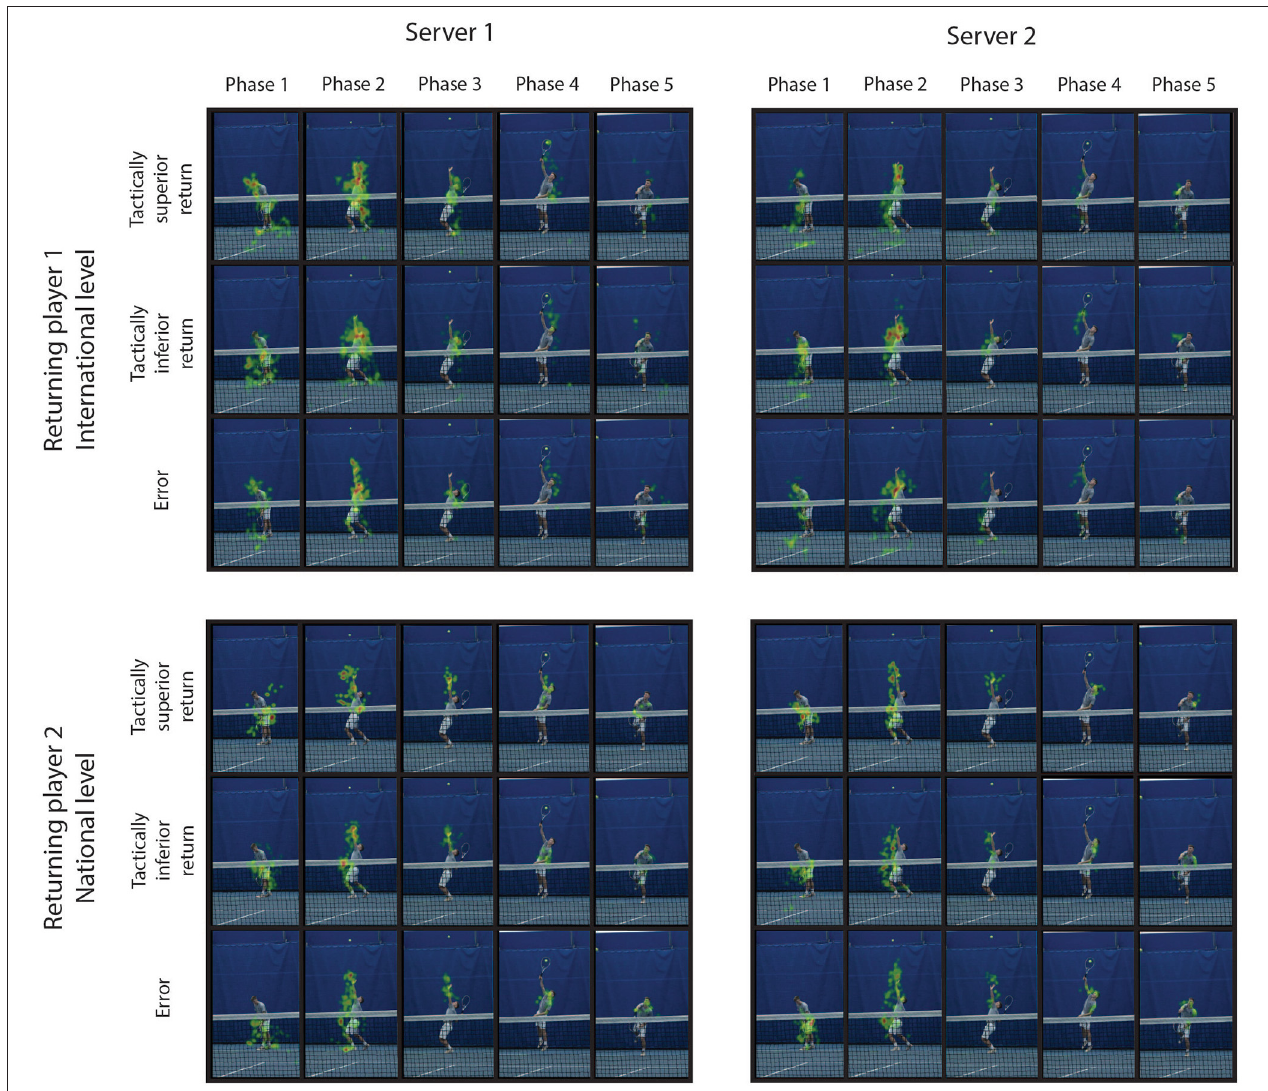
FIGURE 2 | Heat maps show examples of visual behavior in two returning players. Examples of heat maps for two returning players (upper and lower set of heat maps) each belonging to a different group are presented. The left and right sets of heat maps represent visual fixation duration and location while observing two different servers. The upper row of pictures in each individual set of heat maps depicts visual fixation duration in each phase of the movement of a server at tactically superior returns, the middle row depicts tactically inferior returns, and the bottom row represents the returns resulting in